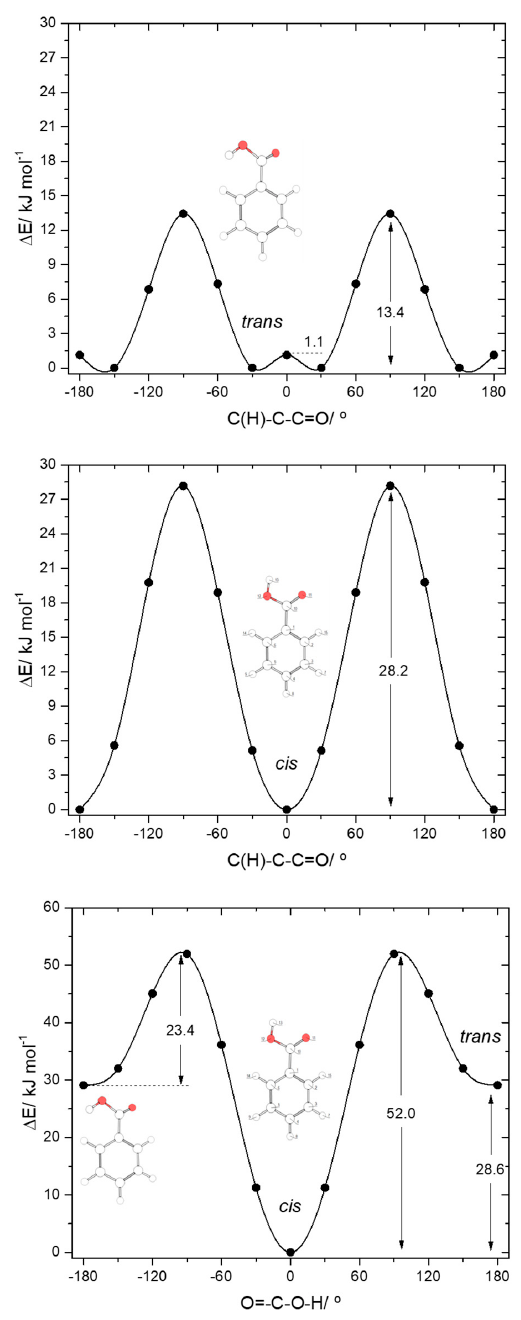
Figure 3. B3LYP/6-311++G(d,p) calculated potential energy profiles for internal rotation about the exocyclic C-C (for cis and trans arrangement of the carboxylic group) ( top and middle panels ) and about the C-O bond (bottom panel) for benzoic acid.